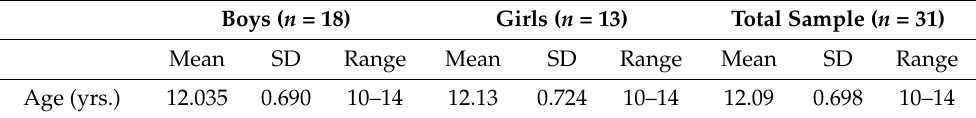
Table 1. Sample Characteristics.